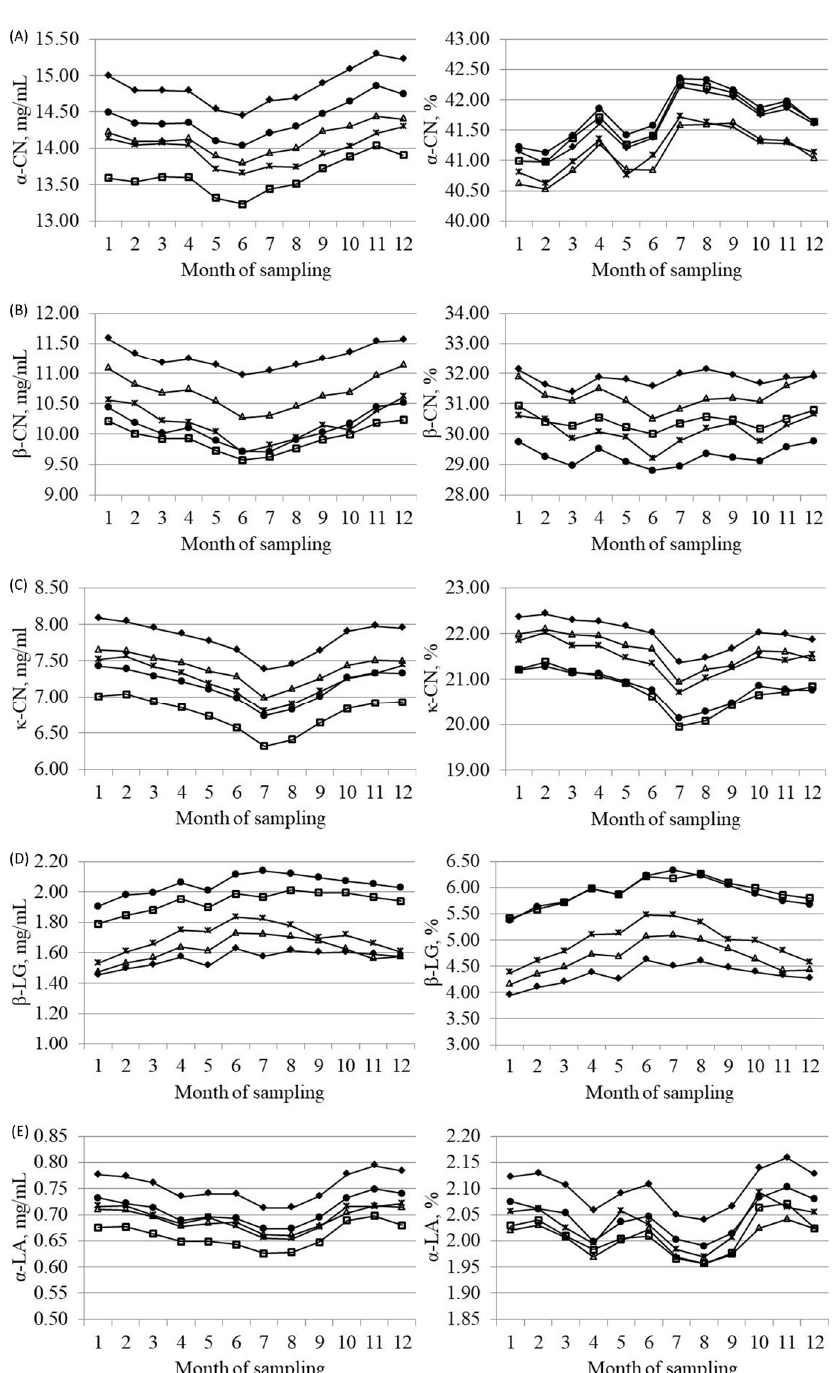
Figure 3. Least squares means of ( A ) α -casein ( α -CN), ( B ) β -casein ( β -CN), ( C ) κ -casein ( κ -CN), ( D ) β -lactoglobulin ( β -LG) and ( E ) α -lactalbumin ( α -LA) across month of sampling for Brown Swiss (- ♦ -), Holstein-Friesian (- □ -), Alpine Grey (- △ -), Simmental (- ● -) and Pinzgauer (-×-) cows, expressed as mg/mL of milk (on the left side) or percentage of crude protein (on the right side).